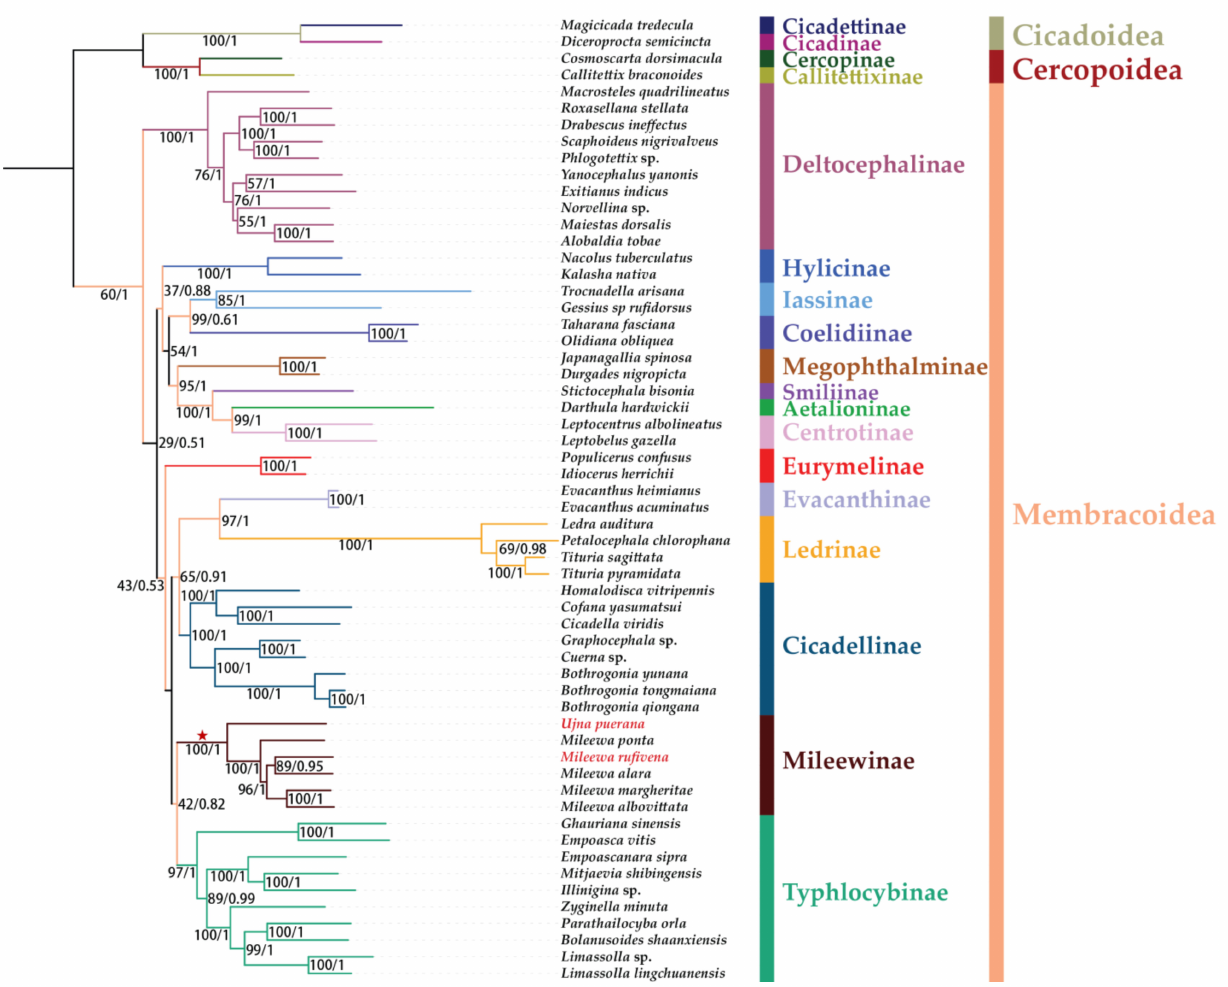
Figure 8. Phylogenetic tree inferred from ML and BI method based on PCG123 dataset. Supports at nodes are bootstrap support values (BS) and posterior probabilities